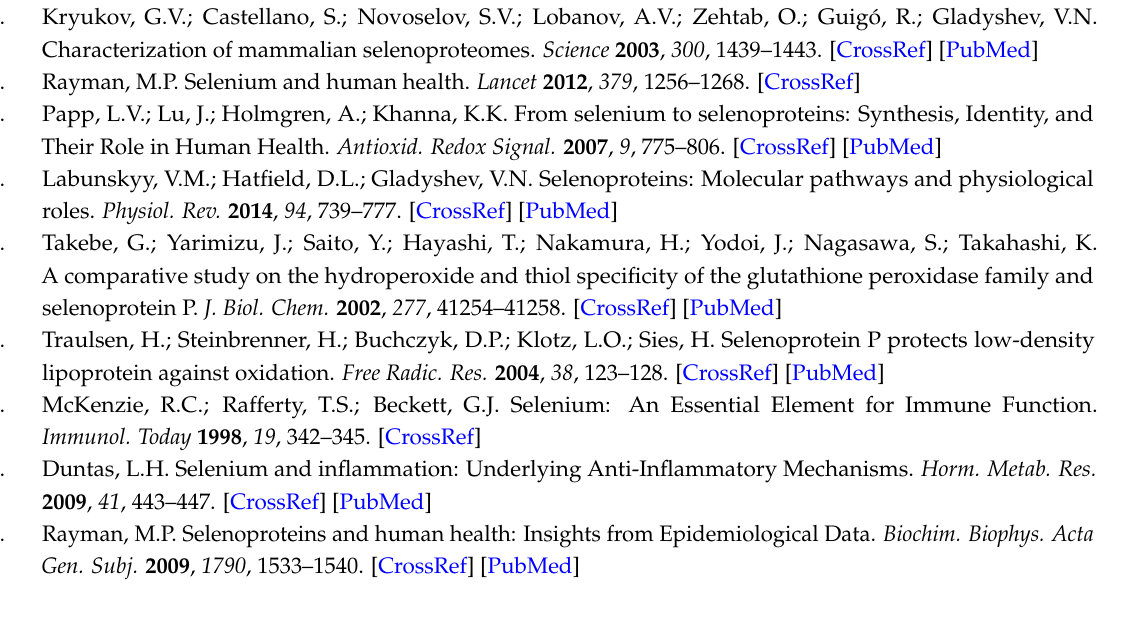
Table S1: Relation between biochemical variables in healthy subjects by linear regression. Figure S1. Relation between biochemical variables in healthy subjects by linear